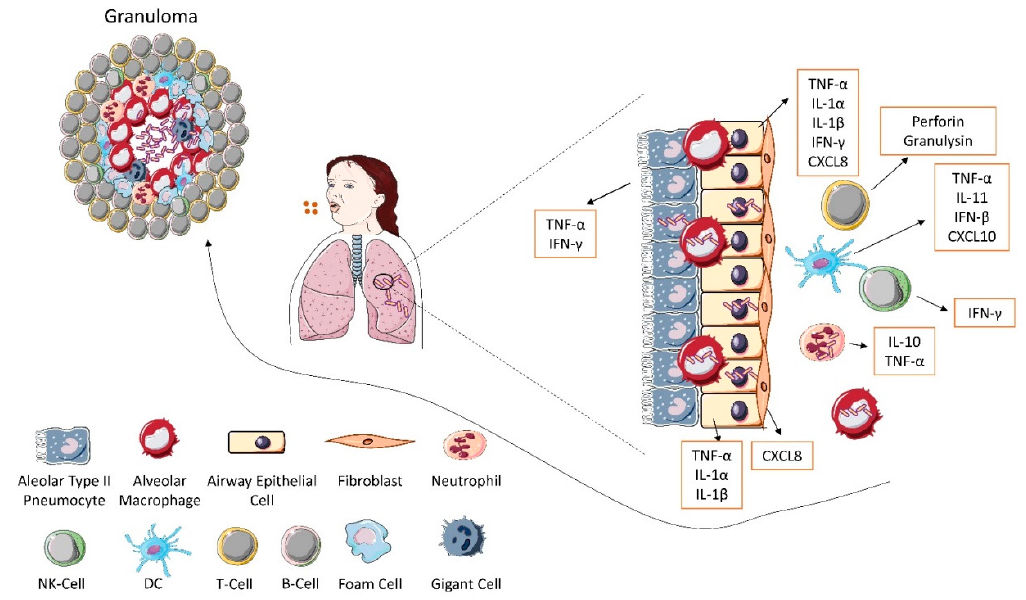
Figure 1. Major cytokines and chemokines involved in antimycobacterial immune